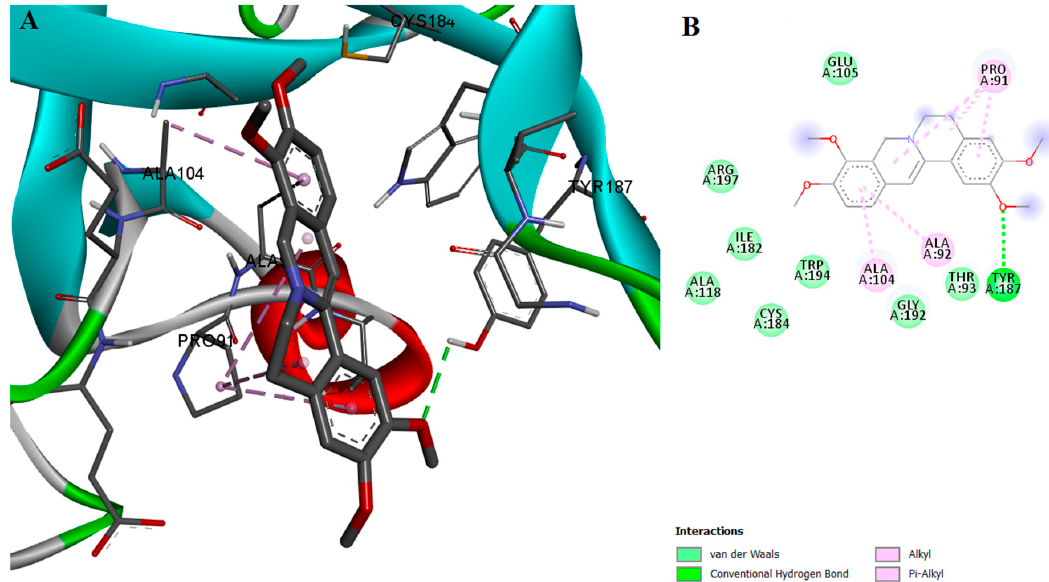
Figure 5. ( A ) Docked conformation and interactions of the palmatine-SrtA complex; ( B ) 2D diagram of the predicted interactions; backbone of the protein is colored in grey, β -helices in turquoise, α -helices in red and loops in green. Ligand-protein interactions are colored depending on their type: conventional hydrogen bonds are colored in green, π - σ and π -alkyl interactions are colored in purple and light purple, respectively.